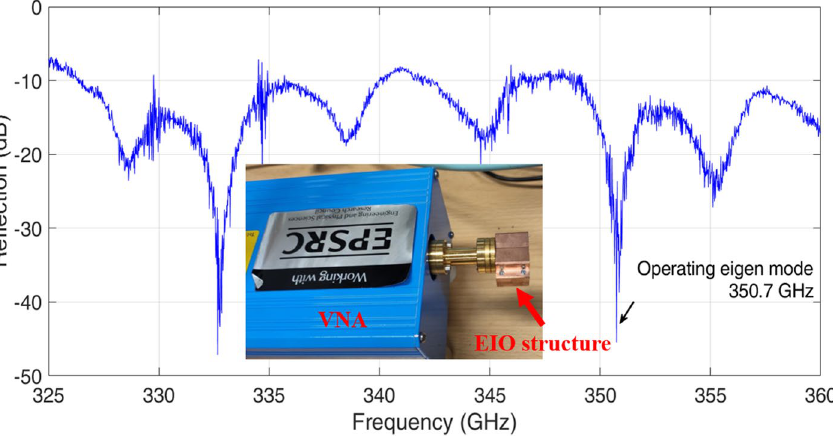
Figure 8. VNA measurement of the 350 GHz EIO.